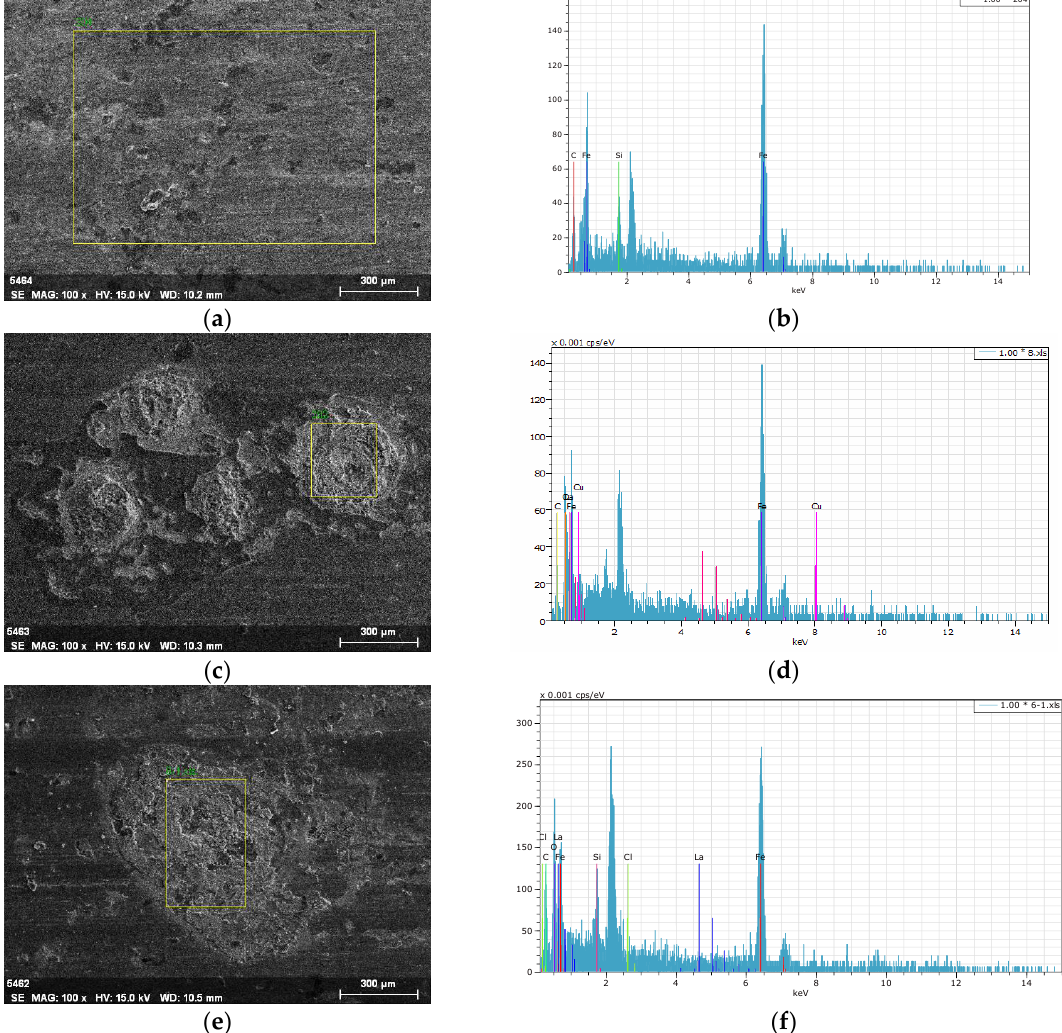
Figure 9. SEM micrographs and EDS spectrums of the counter surface: ( a ) SEM micrograph of the counter surface before tribology testing; ( b ) EDS spectrum of the counter surface before tribology testing; ( c ) SEM micrograph of the counter surface after tribology testing with C 15 L 0 ; ( d ) EDS spectrum of the counter surface after tribology testing with C 15 L 0 ; ( e ) SEM micrograph of the counter surface after tribology testing with C 0 L 15 ; ( f ) EDS spectrum of the counter surface after tribology testing with C 0 L 15 .